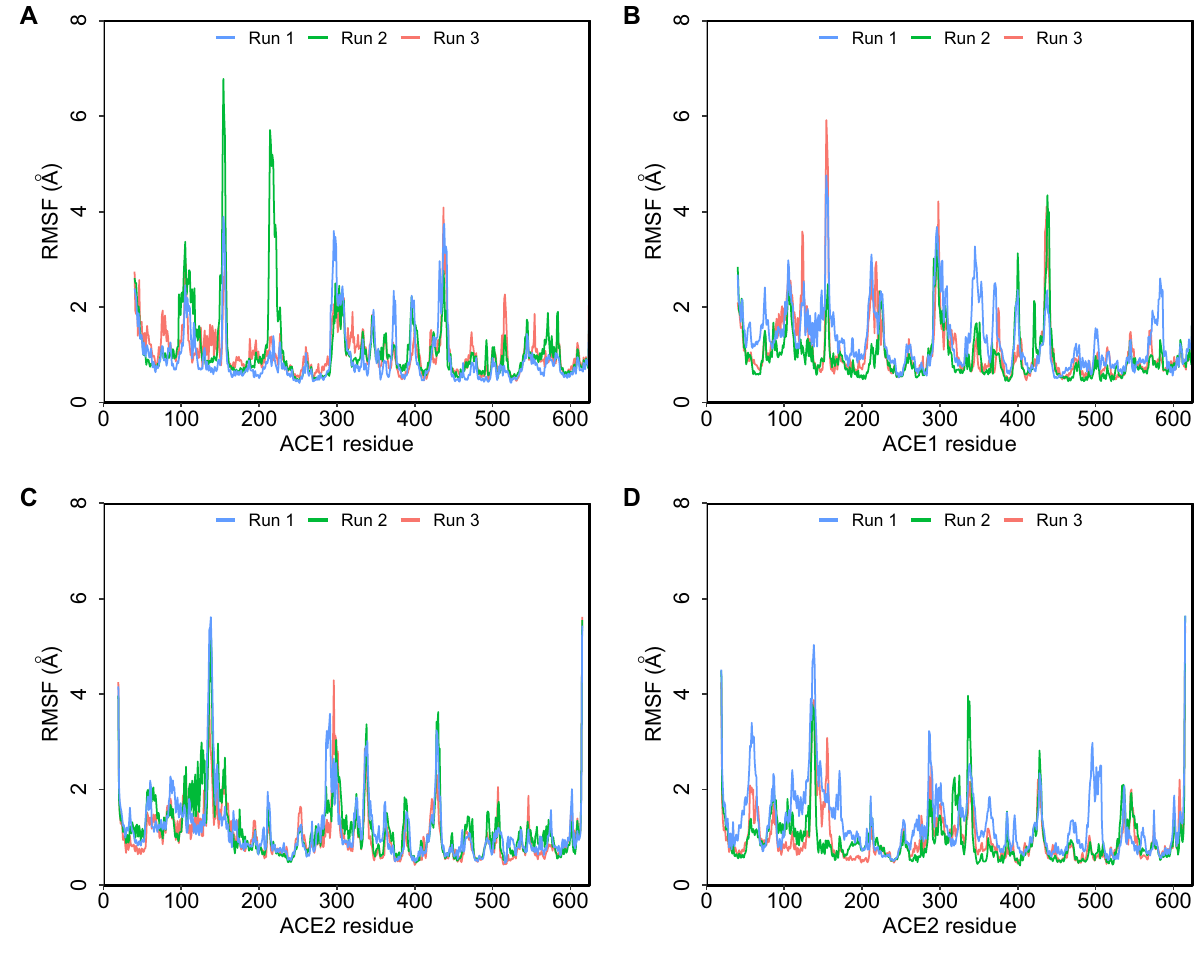
Figure 4. Root mean square fluctuation (RMSF) plots obtained from 500 ns simulations. ( A ) Camel LVVHem6 with ACE1 ( B ) LVVHem6 with ACE1 ( C ) Camel LVVHem6 with ACE2 ( D ) LVVHem6 with